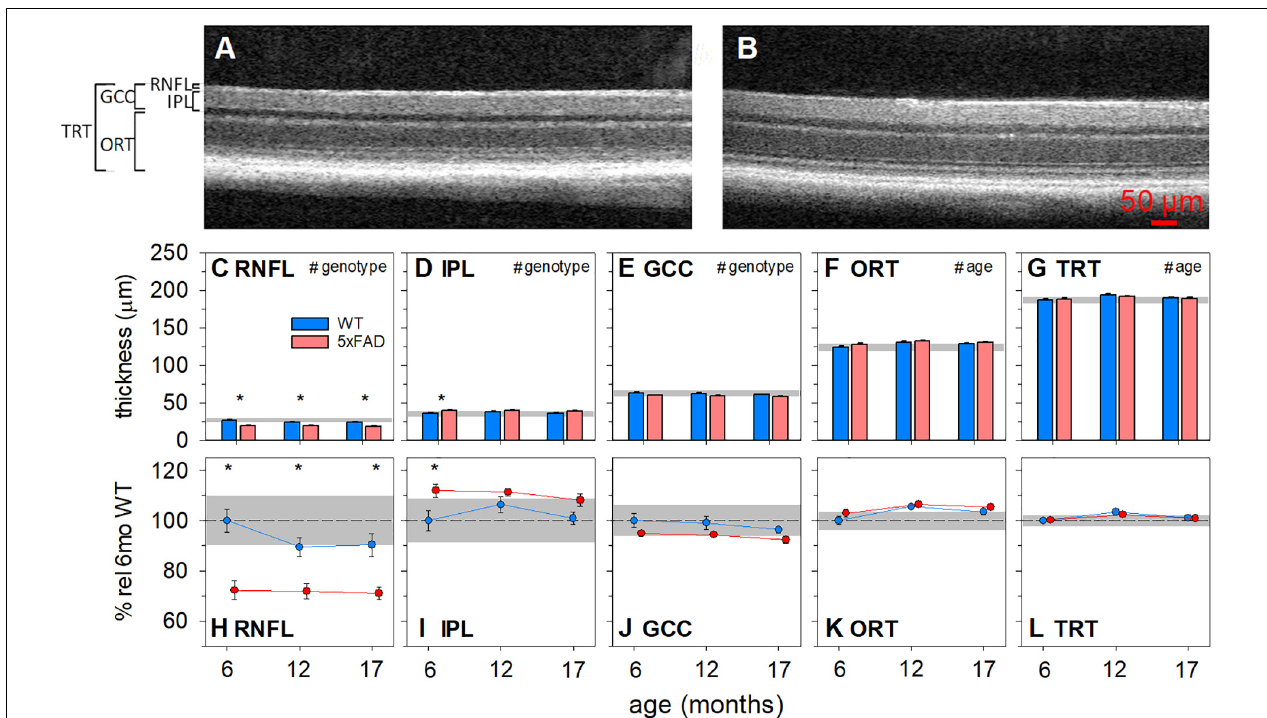
FIGURE 4 | Age-related structural changes in 5xFAD examined using optical coherence tomography. Mouse retinas were assayed for structural changes at 6 (5xFAD n = 8, WT n = 13), 12 (5xFAD n = 12, WT n = 13) and 17 months (5xFAD n = 14, WT n = 16) of age and genotype differences were compared. (A,B) Representative WT and 5xFAD OCT images, respectively. (C–G) Raw retinal thickness values. (H–L) Retinal thickness values expressed as a percentage of 6-month-old WT. RNFL and GCC thickness were significantly reduced and IPL was significantly increased in 5xFAD mice. No significant changes were found in ORT or TRT. Scale bar, 50 µ m; RNFL, retinal nerve fiber layer; IPL, inner plexiform layer; GCC, ganglion cell complex; ORT, outer retinal thickness; TRT, total retinal thickness; Error bars, SEM; Gray shaded area, 95% CI for 6-month-old WT; # p < 0.05 for treatment effect on two-way ANOVA analyses; * p < 0.05 for Bonferroni post hoc